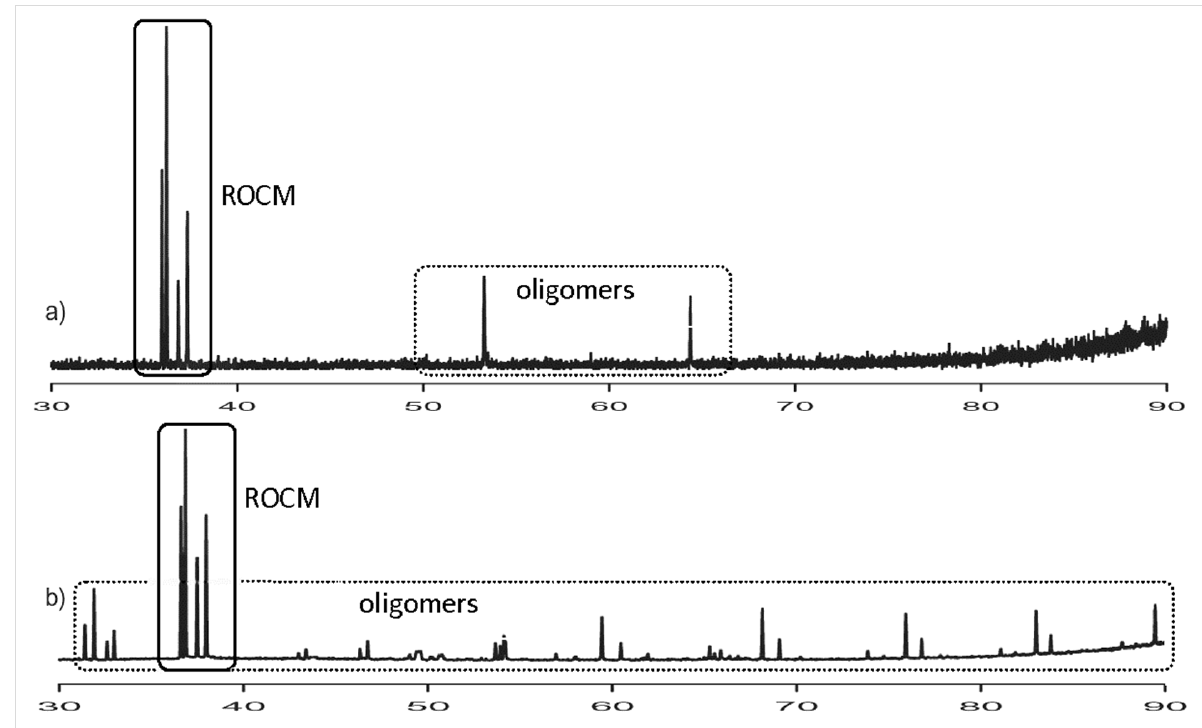
Figure 2: Representative GC chromatograms recorded from crude reaction mixtures described in Table 1: a) entry 1 and b) entry 5.